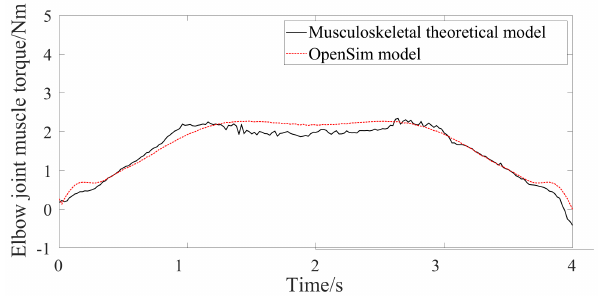
Figure 15. Predicted elbow muscle torque.